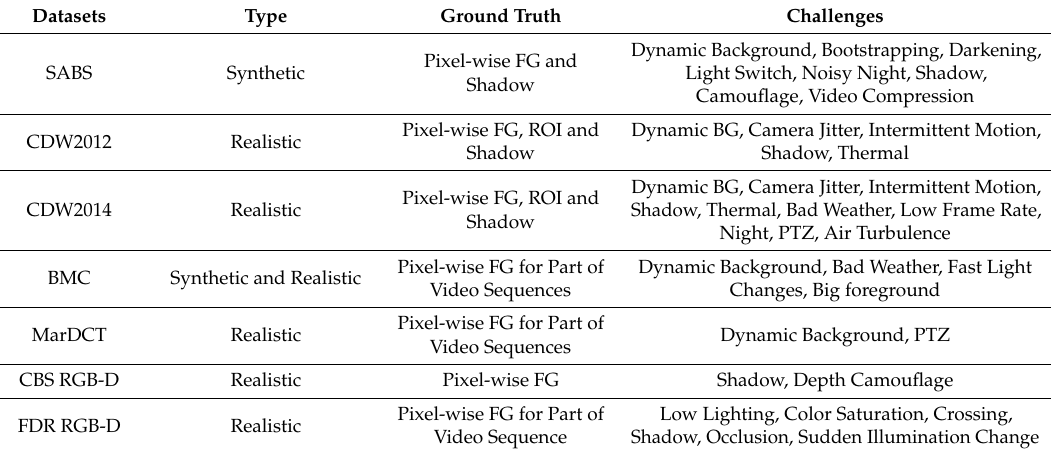
Table 1. Introduction of the datasets recently developed for background